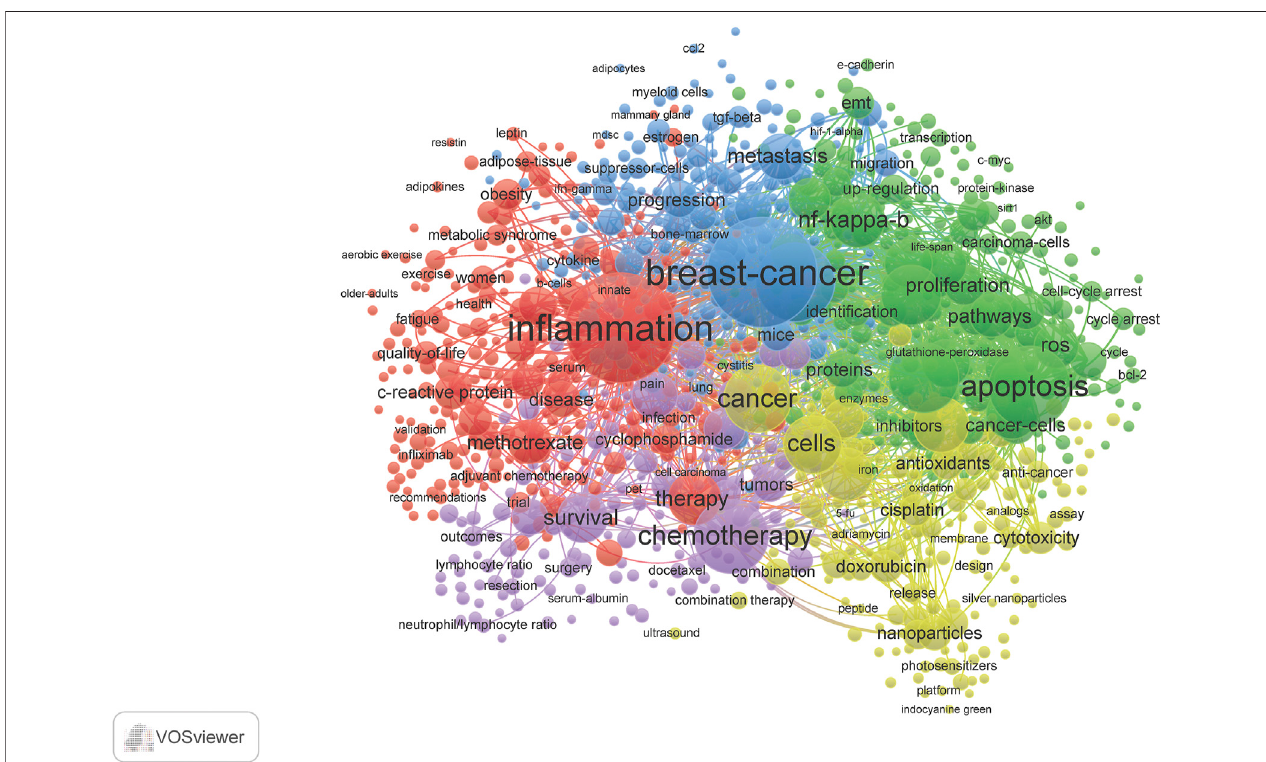
FIGURE 4 | Term map showing the visualization of 669 terms that occurred at least 10 times in documents between 2000 and 2009. Refer to Supplementary Table S3 for complete list of terms.